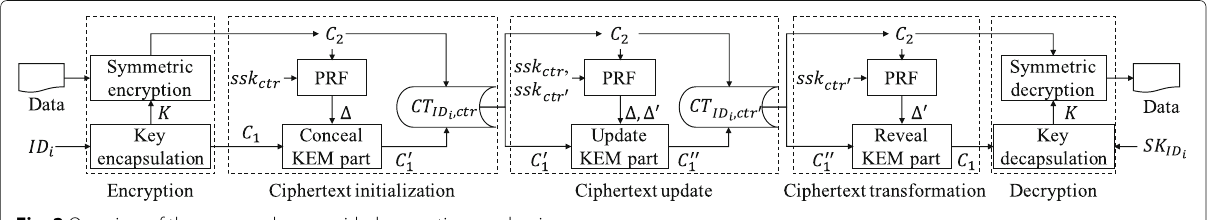
Fig. 2 Overview of the proposed server-aided revocation